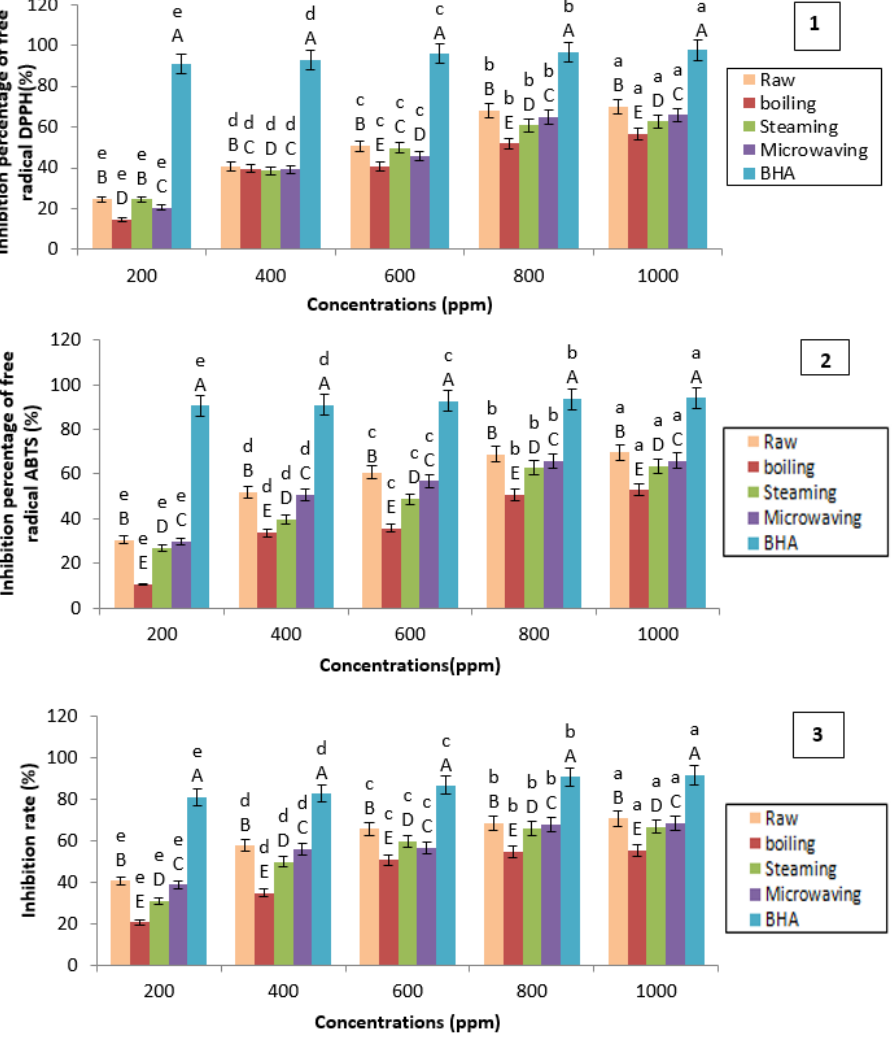
Figure 14. Evaluation of antioxidant activity: 1 : 1,1-diphenyl-2-picryl-hydrazyl (DPPH) method; 2 : 2,2′-azino-bis(3-ethylbenzothiazoline-6-sulphonic acid) (ABTS) method; 3 : Cupric reducing antioxidant capacity (CUPRAC) method. BHA: Butylated hydroxyanisole. The superscript letters A, B, C, D, and E indicate a significant difference between antioxidant activities of raw and cooked potatoes at the same concentration of extract (ppm) (at the 0.05 significance level. The superscript letters a, b, c, d, and e indicate a significant difference between antioxidant activities of raw and cooked potatoes at different concentrations of extract (ppm) at the 0.05 significance level.